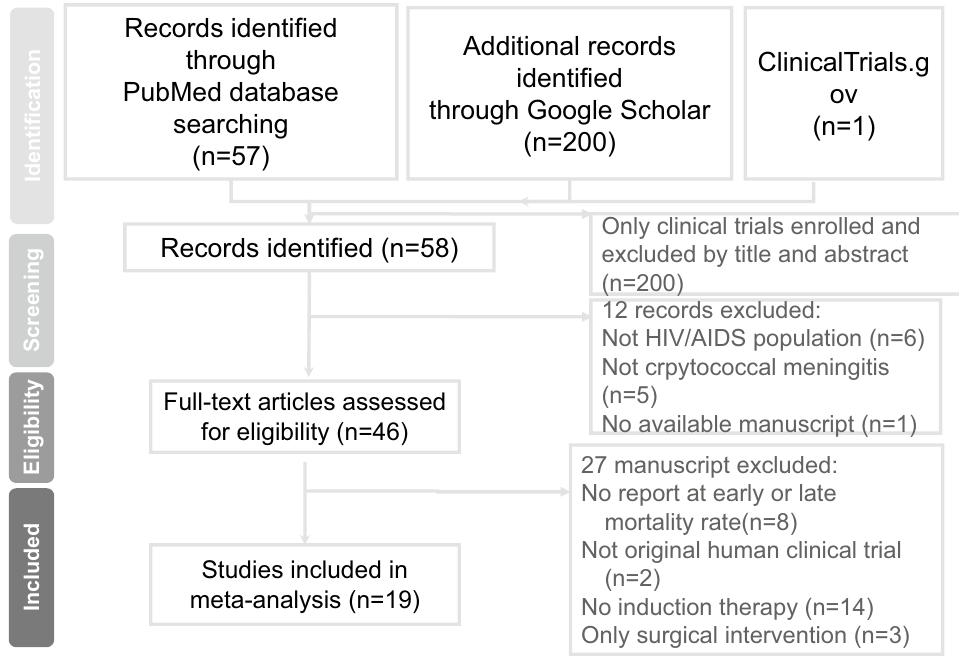
Figure 1. Flowchart of the current network